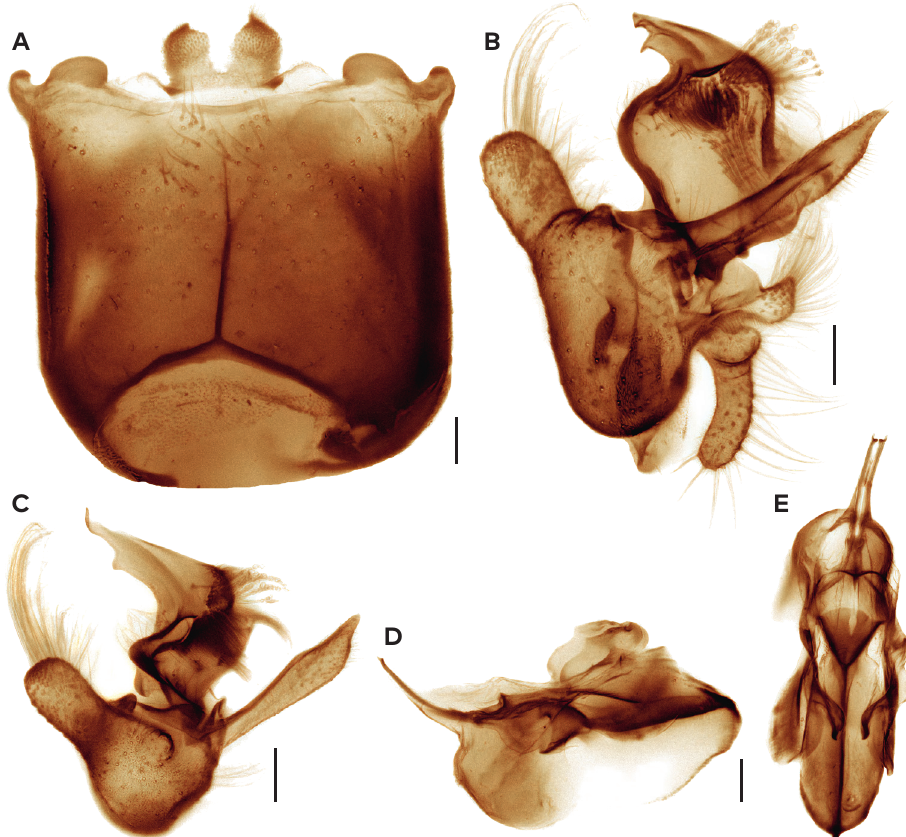
Figure 2. Male terminalia of Phyllolabis savtshenkoi , details: A 9 th tergit, dorsal; B gonopodit,